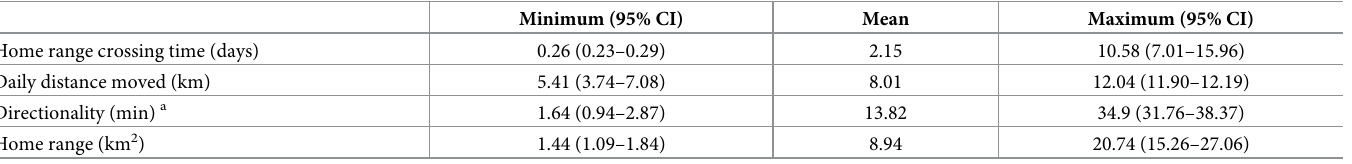
Table 1. Estimates and confidence intervals of movement patterns (described by home range crossing time, daily distance moved and directionality) and home range size of giant anteaters ( Myrmecophaga tridactyla ). Home range crossing time